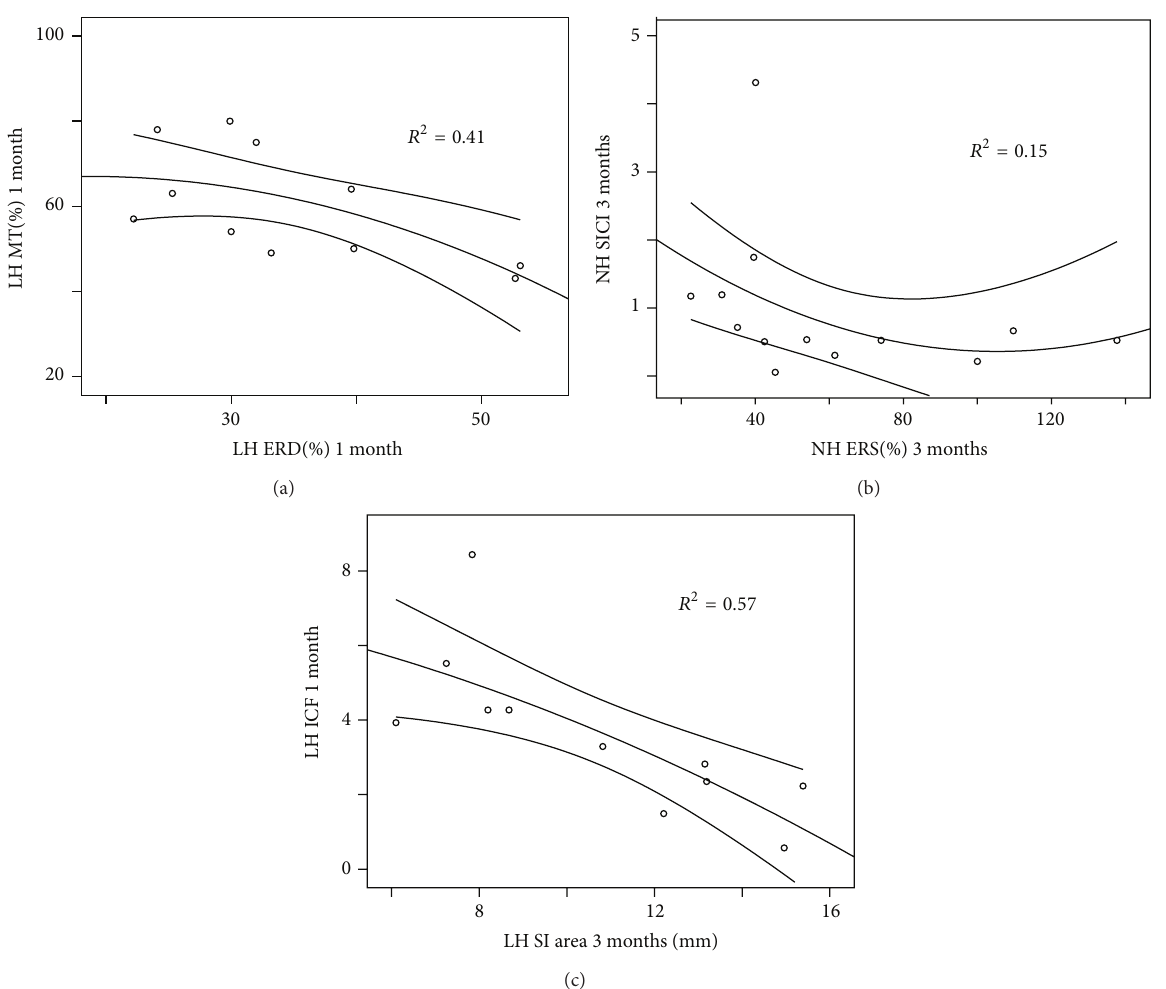
Figure 1: Scatterplots, quadratic fits, and 95% confidence intervals of the motor thresholds and ERD values in the lesioned hemisphere at 1 month (a), SICI and ERS values in the nonlesioned hemisphere at 3 months (b), and ICF values at 1 month and SI area at 3 months in the lesioned hemisphere